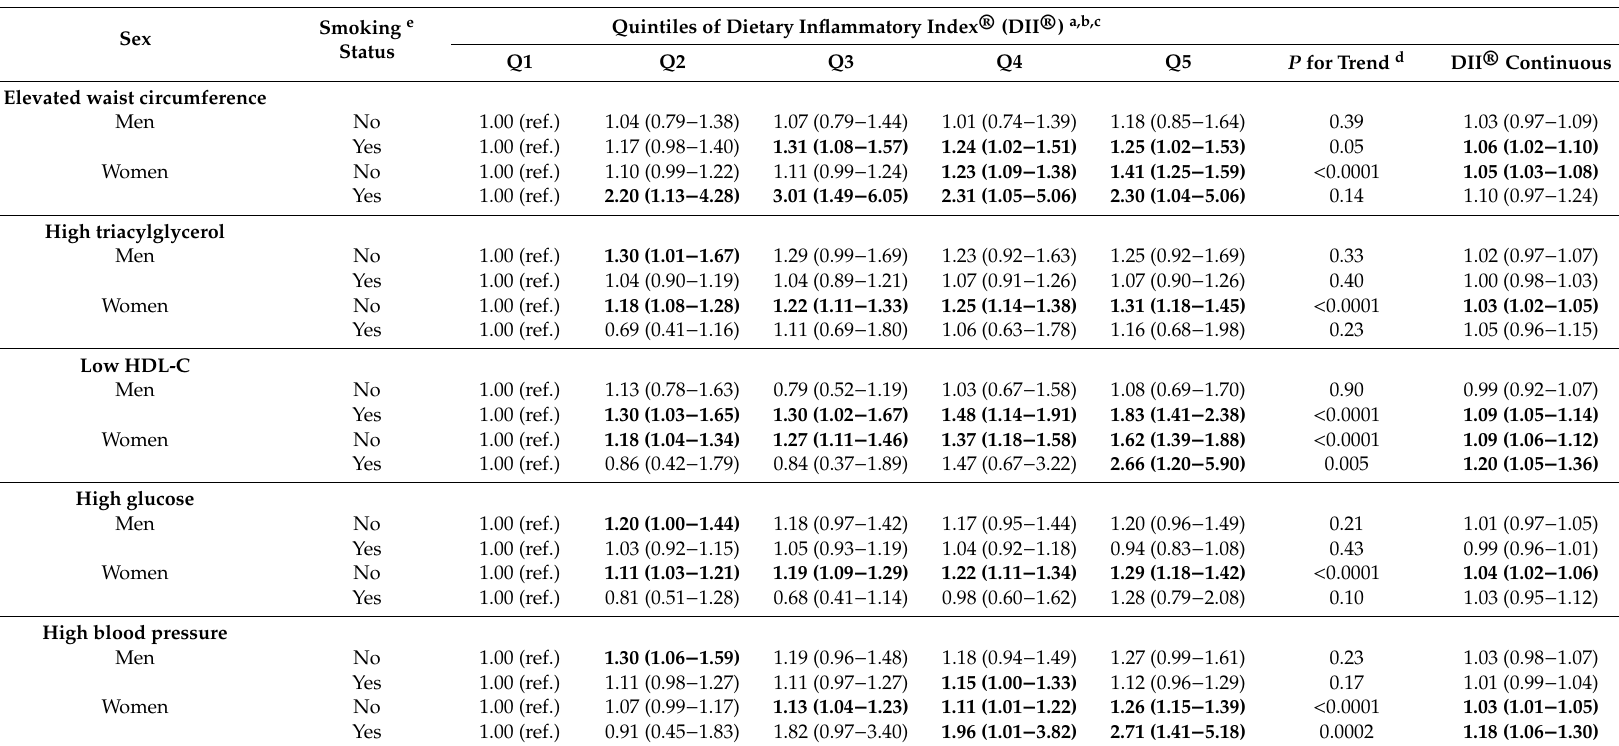
Table 4. Hazard ratios (HRs) and 95% confidence intervals (CIs) for risk of components of metabolic syndrome as stratified by